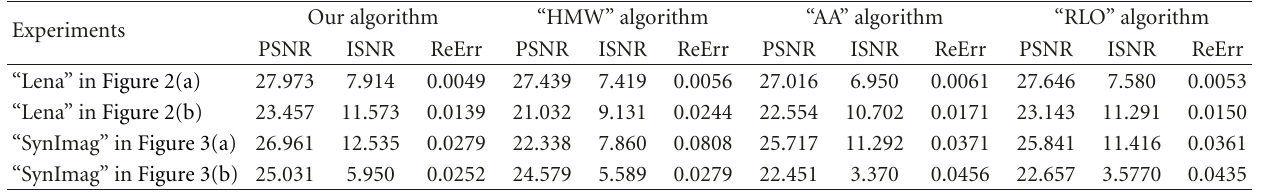
Table 2: The number of iterations and computational times of four algorithms. Our algorithm “HMW” algorithm Experiments Iterative “Lena” in Figure